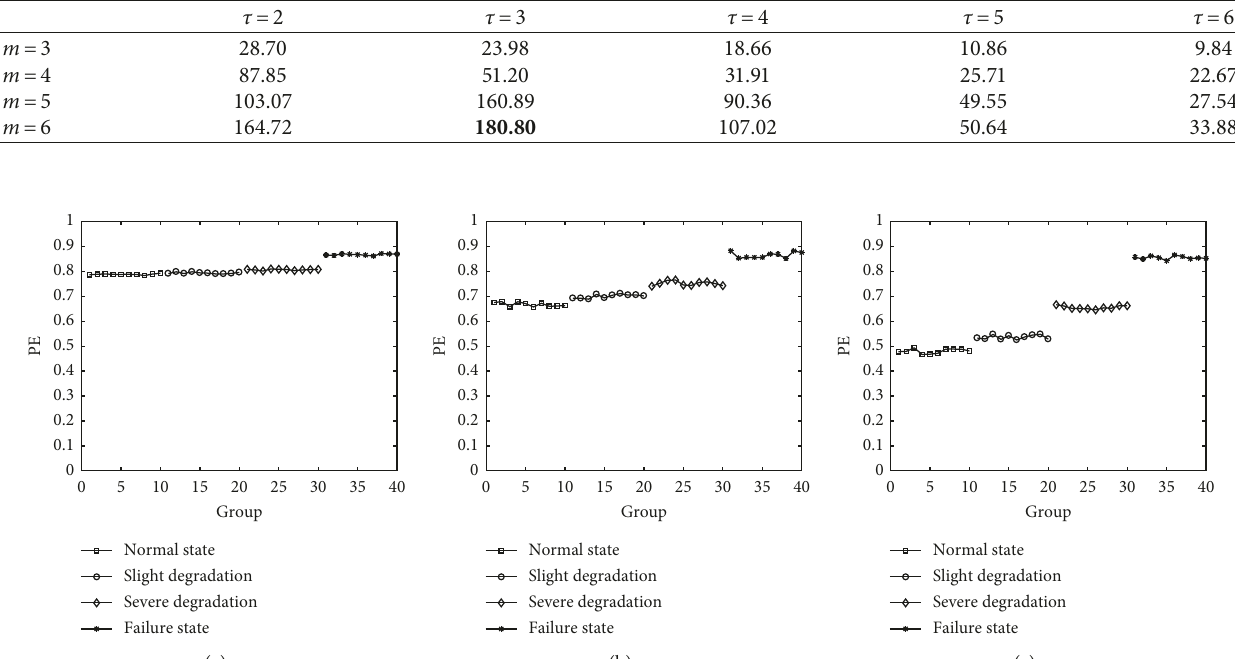
3, τ 6, and α Z (cid:31) (cid:31)